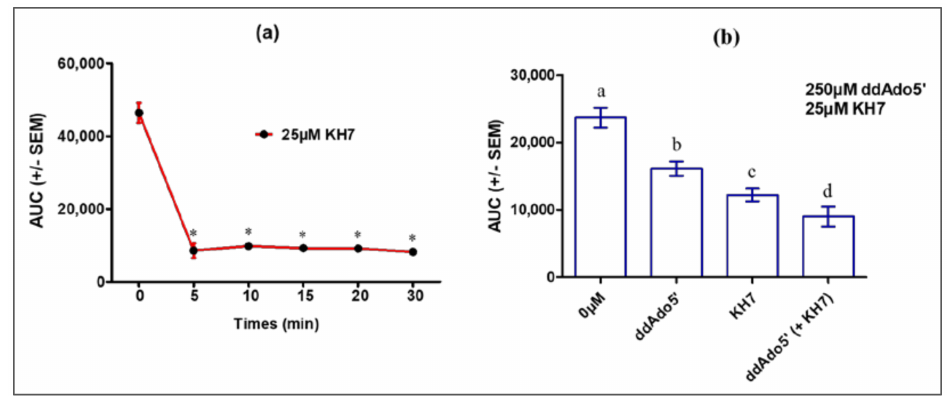
Figure 6. Effects of KH7 and ddAdo5 (cid:48) on the intracellular cAMP response to 0.7 nM hLH in MLTC-1 cells. ( a ) Kinetics of KH7 action: MLTC-1 was incubated with 25 µ M KH7 for 0–30 min before the addition of hLH and luminescence was recorded for 30 min after hLH introduction; ( b ) Effects of separate or concomitant actions of KH7 and ddAdo5 (cid:48) . MLTC-1 was incubated with 250 µ M ddAdo5 (cid:48) for 25 min and then exposed to 25 µ M KH7 for 5 min. The values are means ± SEM for n = 3 independent experiments. p value of < 0.05 was considered statistically significant using a one-way ANOVA followed by the Dunnett’s test post-test. Different letters or asterisk indicate significant differences between control (0 µ M) and treatment at p < 0.05. ns = not statistically